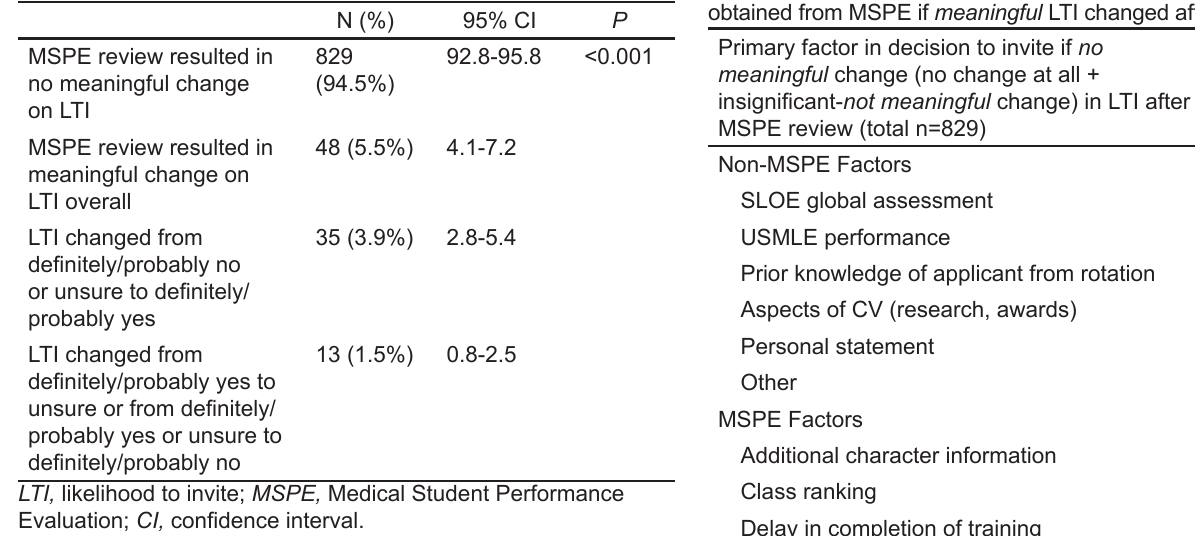
Table 4. Effect of Medical Student Performance Evaluation on likelihood to invite (LTI) and characteristics of LTI